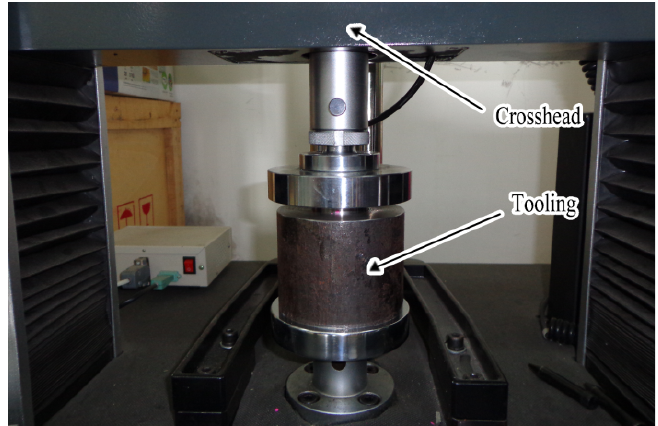
Figure 3. Micro sheet stamping